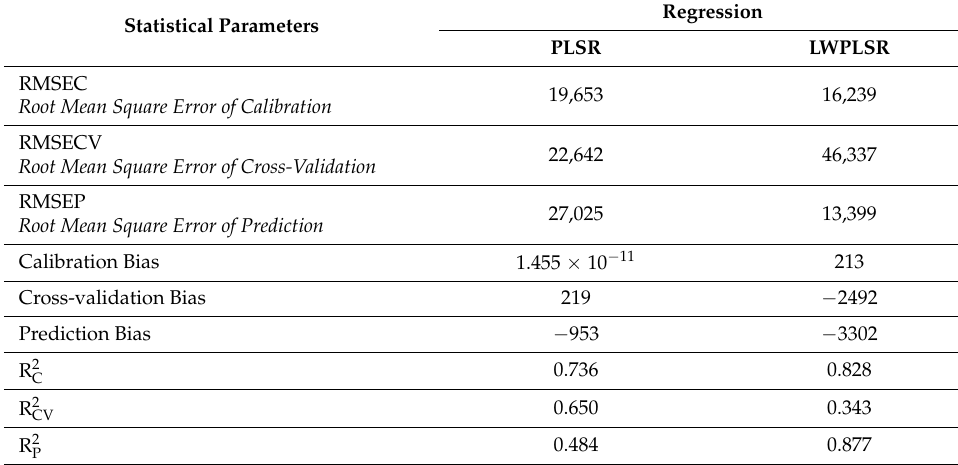
Table 1. The partial least squares regression (PLSR) and the locally weighted partial least squared regression (LWPLSR) results for bromine content from SWIR reflectance